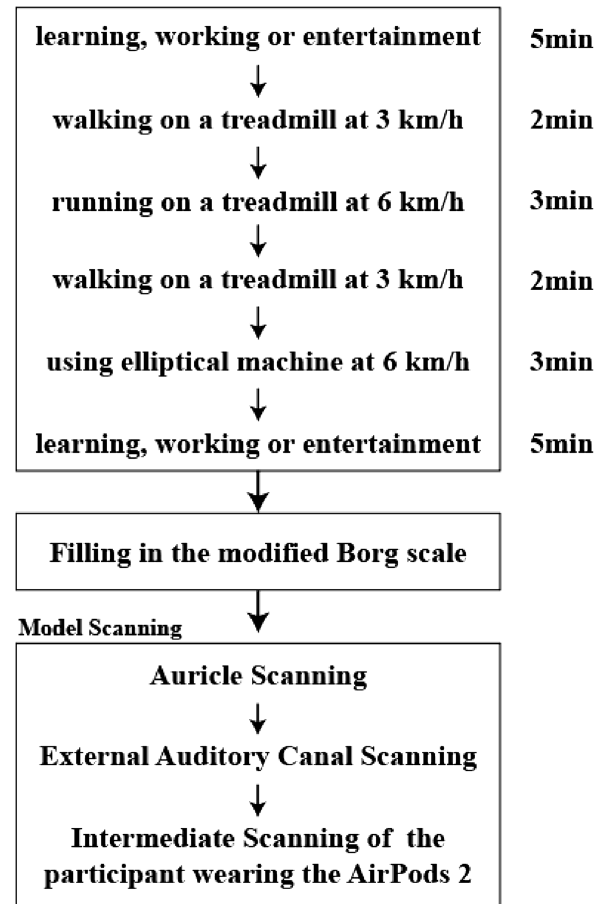
Figure 7. Evaluating